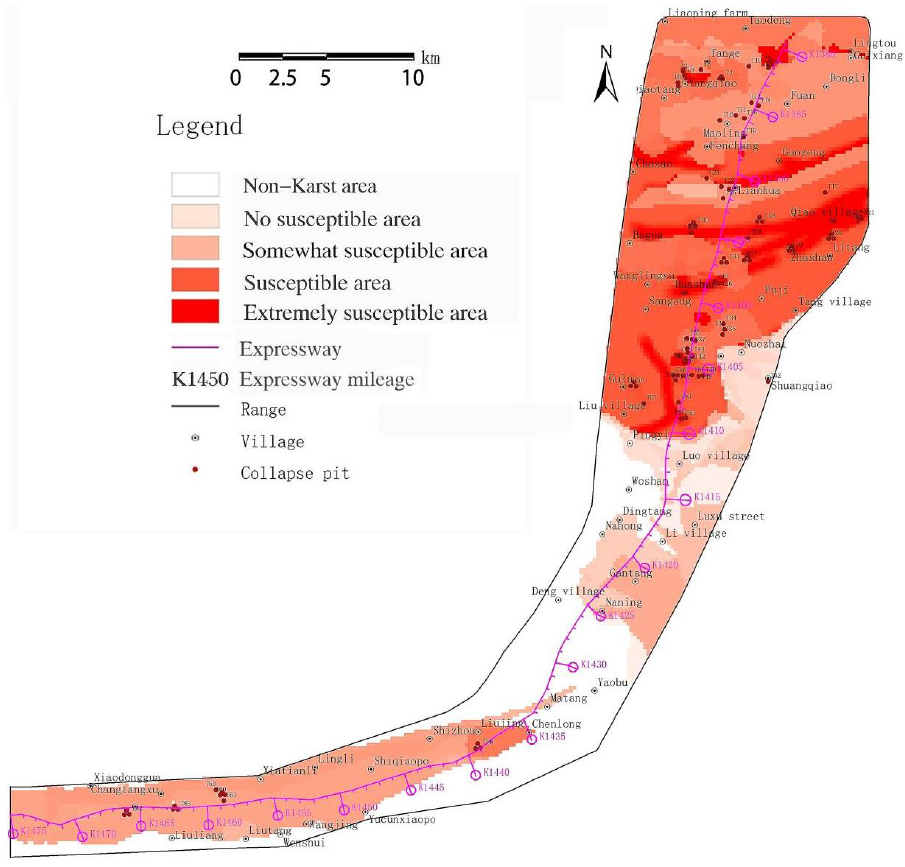
Figure 15. Zoning map of karst collapse susceptible prediction evaluation in the study area.